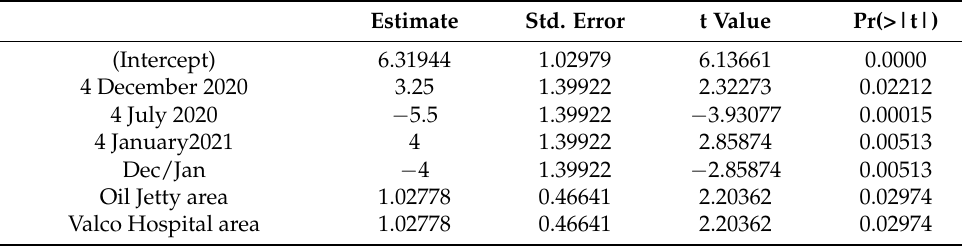
Table 4. Significant variables estimates for NO 2